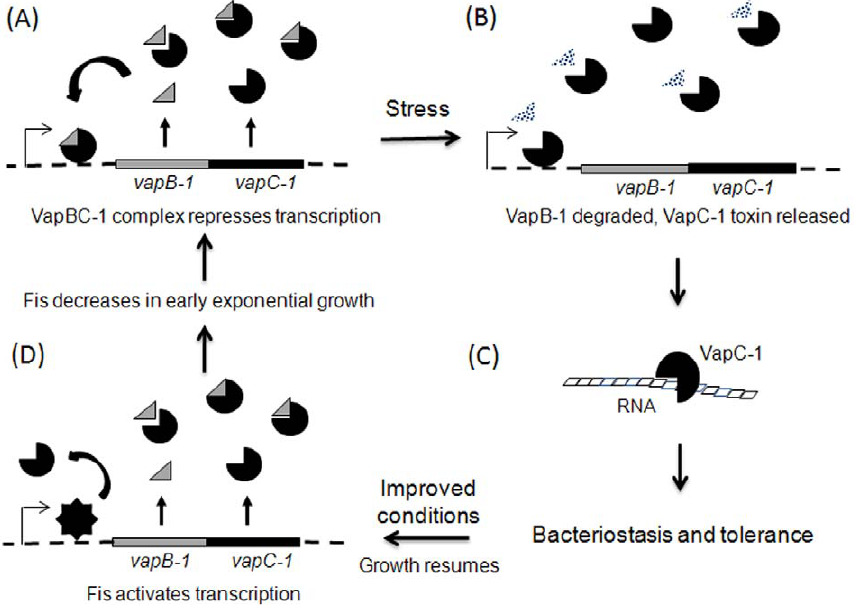
Figure 9. Model for the regulation of the vapBC-1 locus. (A) During colonization under favourable conditions, the VapBC-1 complex binds to and autorepresses TA operon transcription. (B) Stress induces Lon and Clp proteases that degrade VapB-1, releasing active VapC-1 toxin. (C) The ribonuclease activity of VapC-1 facilitates a state of bacteriostasis, resulting in nonspecific antibiotic tolerance. (D) Upon improved conditions, Fis activates vapBC-1 operon transcription, displacing any bound VapC-1. Fis levels decrease in early exponential growth, allowing the VapBC-1 complex to bind and restore transcriptional equilibrium.